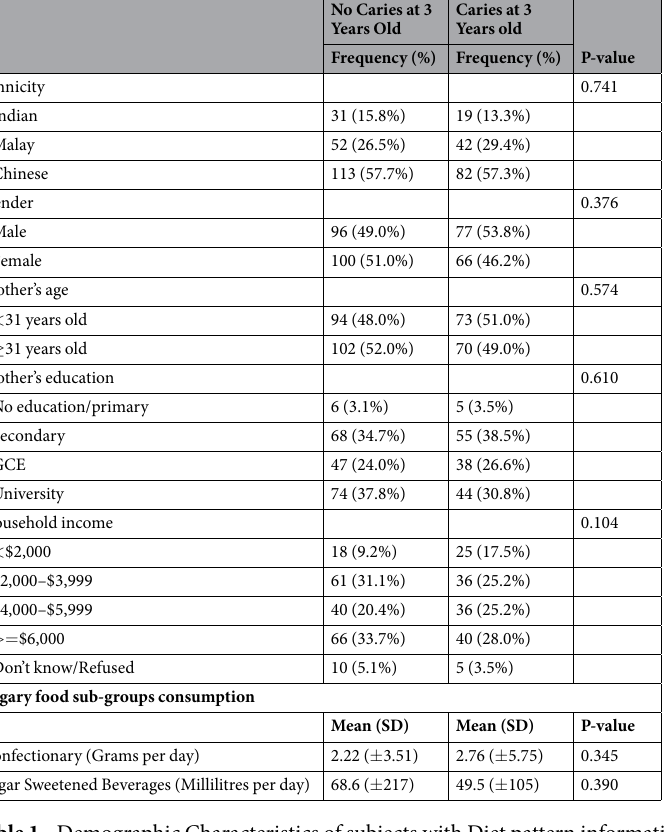
Table 1. Demographic Characteristics of subjects with Diet pattern information and Oral exam at 3 years old (n = 339) and Sugary food sub-groups consumption.